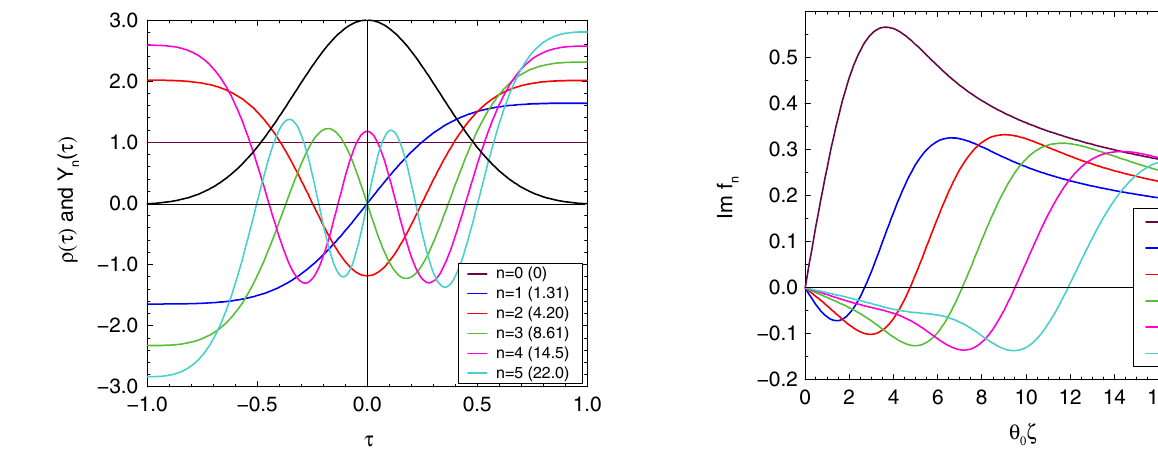
−1.4−1.2−1.0−0.8−0.6−0.4−0.20.0